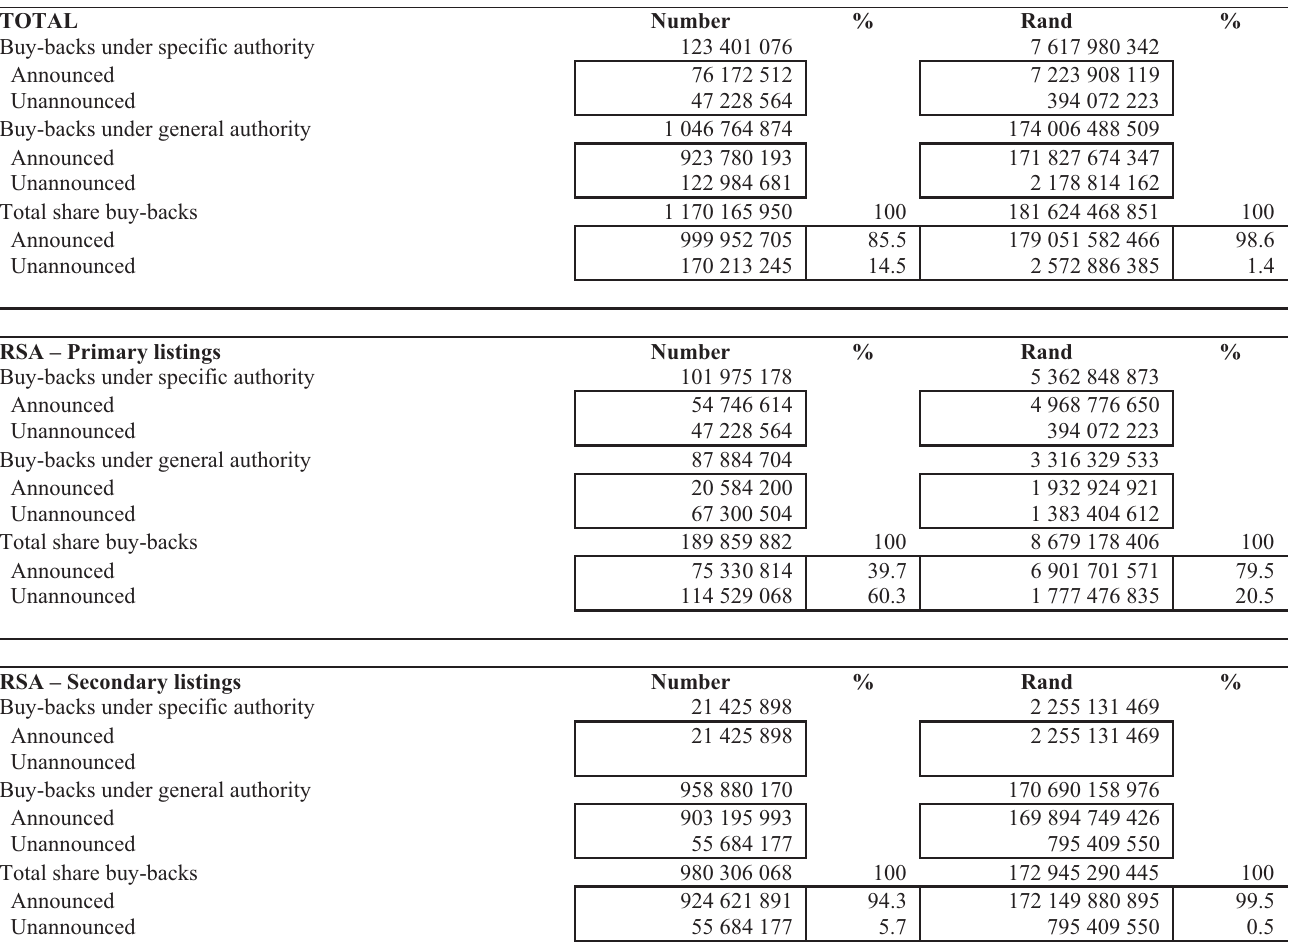
Table 5: Share buy backs: Announced versus unannounced TOTAL Number % Rand % Buy-backs under specific